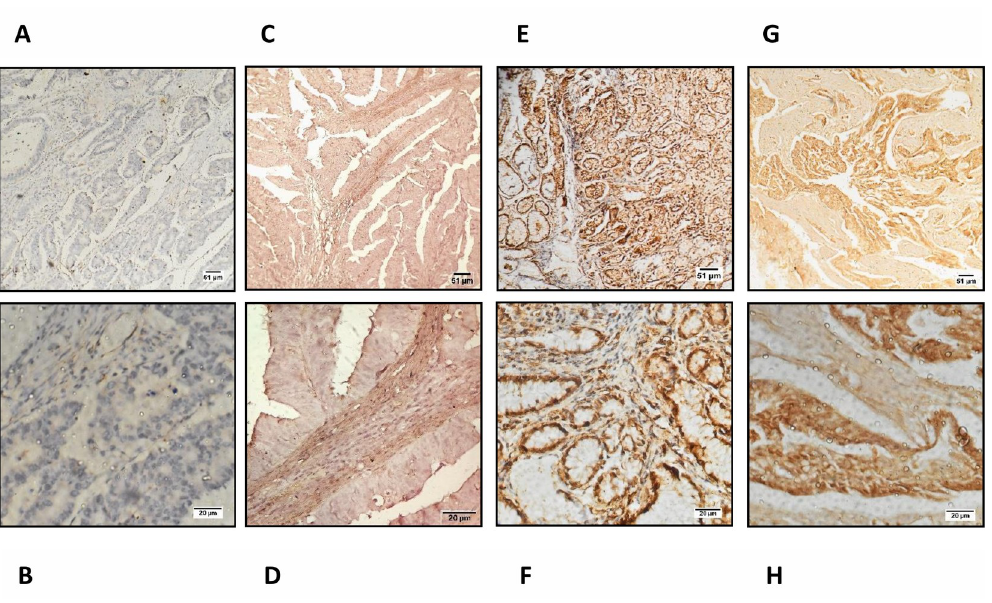
Fig 4. Upregulation of ASPN in gastric tumors: Immunohistochemical staining of ASPN expression in gastric cancer tissue and the criteria for immunohistochemistry scoring. Representative IHC staining comparing ASPN expression in FFPE gastric tissues from GC patients. IHC staining is scored according to semi-quantitative immune-reactivity scoring. Score 0: no staining, score 1: weak staining, score 2: moderate staining, score 3: strong staining. Images of the gastric samples were taken at 100X and 400X magnification In, (A, B) (patient ID# OT63 Normal) Staining Intensity is 0; (C, D) (patient ID# CMCOT02 Tumor) staining intensity is 1; (E, F) (patient ID# 18S292 Tumor) represents the staining intensity of 2 and Fig. (G, H) (patient ID# OT 15 Tumor) represents the staining intensity of 3. Scale bars: 100X = 51 μ m and 400X = 20 μ m. (S4 Table).